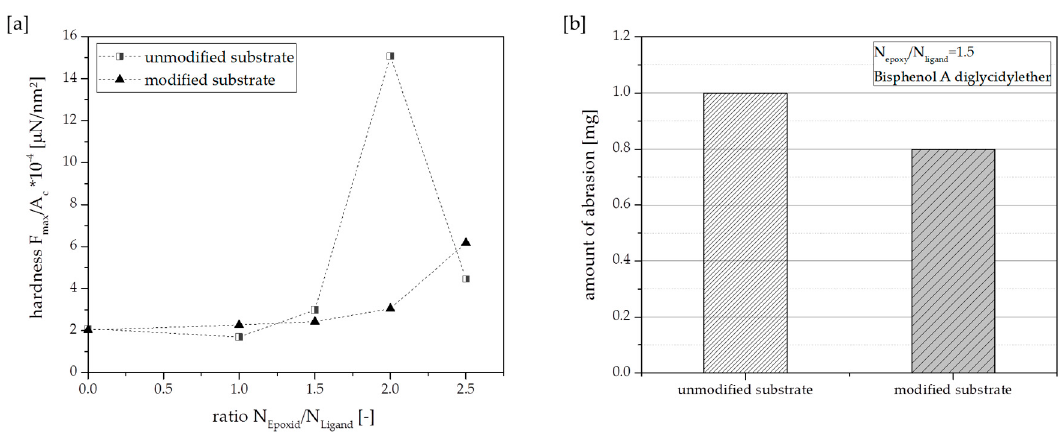
Figure 7. Hardness of coating on unmodified and modified substrates ( a ); amount of abrasion using unmodified and modified substrates ( b ).